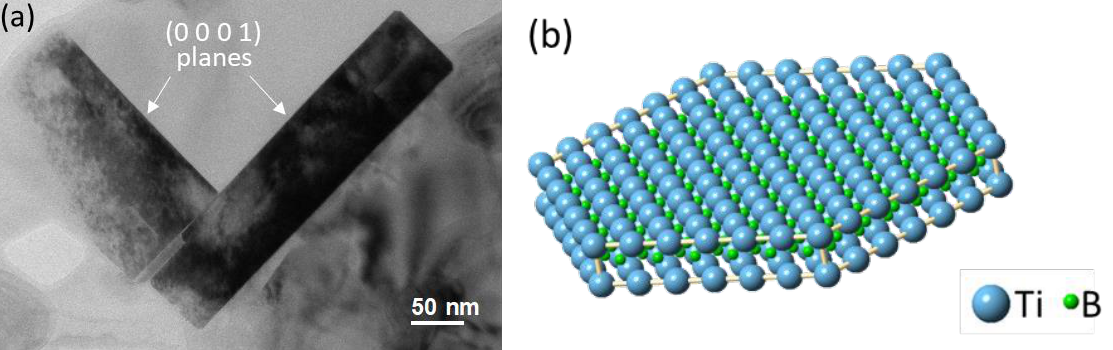
Figure 2. Surface termination and morphology of TiB 2 particles [11]. ( a ) TEM bright field image showing that the hexagonal TiB 2 particles are faceted with their {0 0 0 1} basal and {1 1 0 0} prismatic planes; and ( b ) 3D illustration showing schematically the atomic arrangement of TiB 2 crystal.